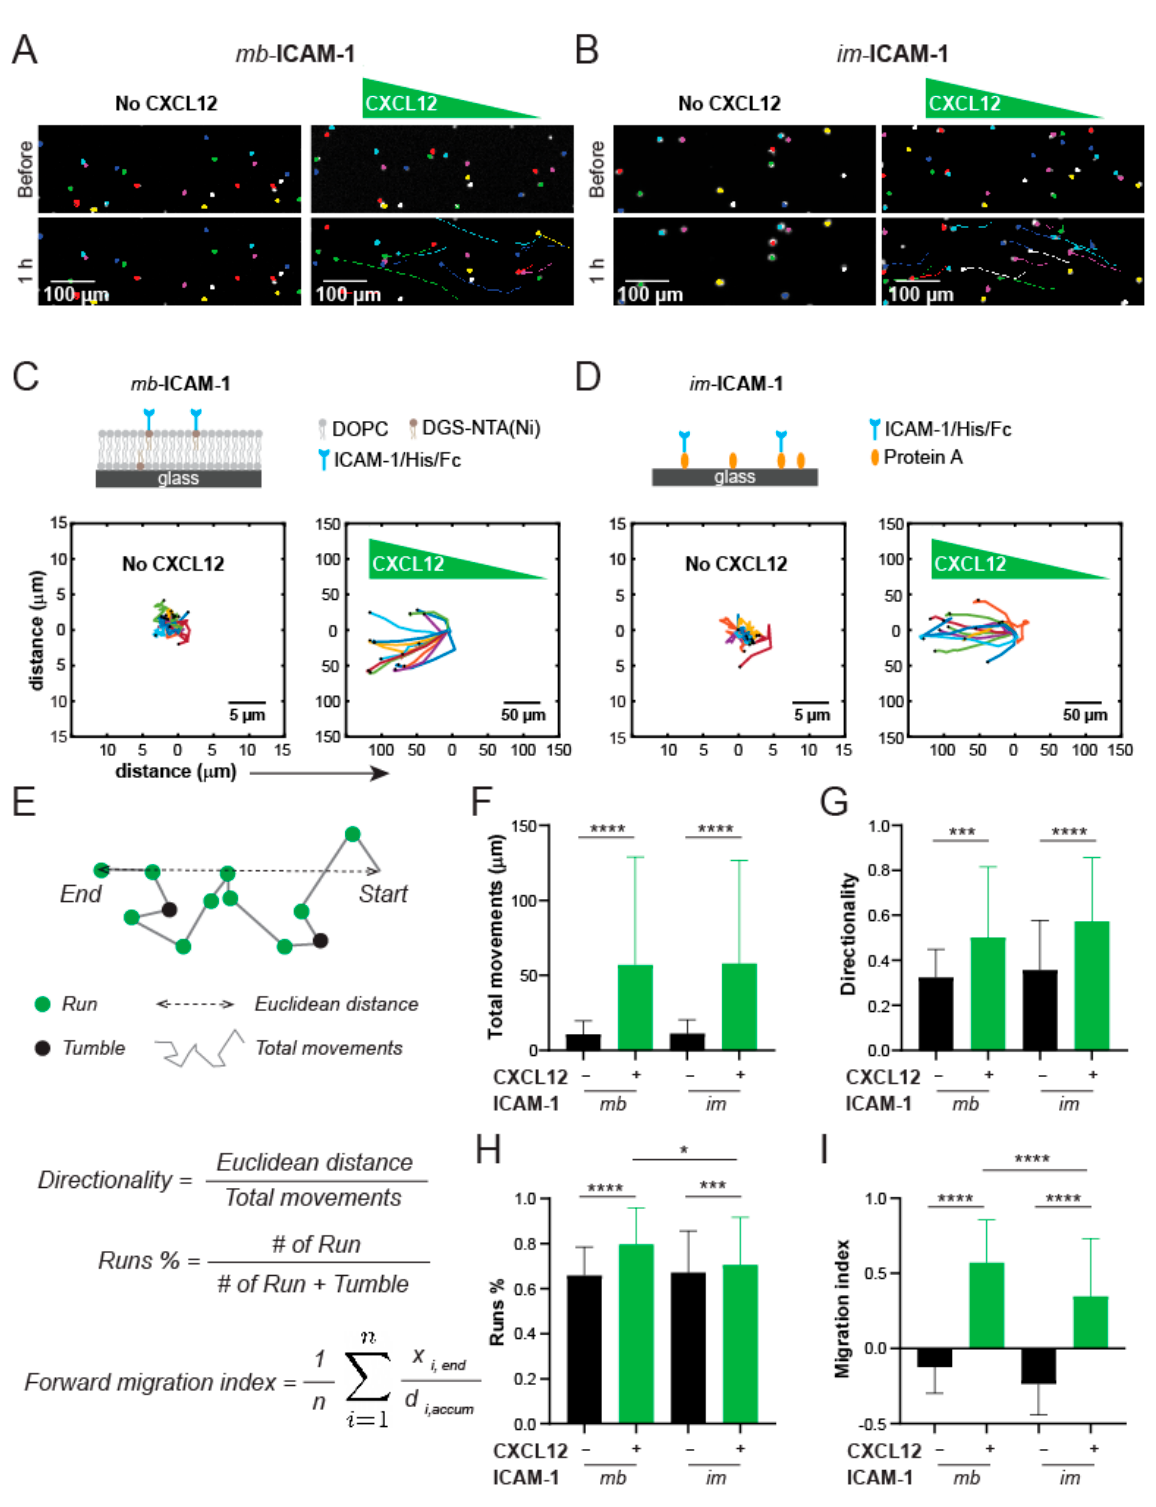
Figure 6. Jurkat cell chemotaxis towards CXCL12 on membrane-bound vs. immobilized ICAM-1 in the diffusion microdevice. Representative images of Jurkat cells and migration trajectories in 1 h with and without CXCL12 gradient, ( A ) mb-ICAM-1 and ( B ) im-ICAM-1, respectively. The migration trajectories of Jurkat T cells in 1 h on ( C ) mb-ICAM-1 and ( D ) im-ICAM-1 without and with CXCL12 gradient. ( E ) Schematic of the definitions of cell migration parameters. Quantifi- cation of ( F ) total movements, ( G ) directionality, ( H ) migration persistency as assessed by Runs% and ( I ) forward migration index, as assessed by averaged movement toward chemoattractant gradient over accumulated distance. n = 66–71 single cell trajectory per condition. Not specified: p > 0.05; *: p < 0.05; ***: p < 0.001; ****: p < 0.0001 by ANOVA with Tukey’s